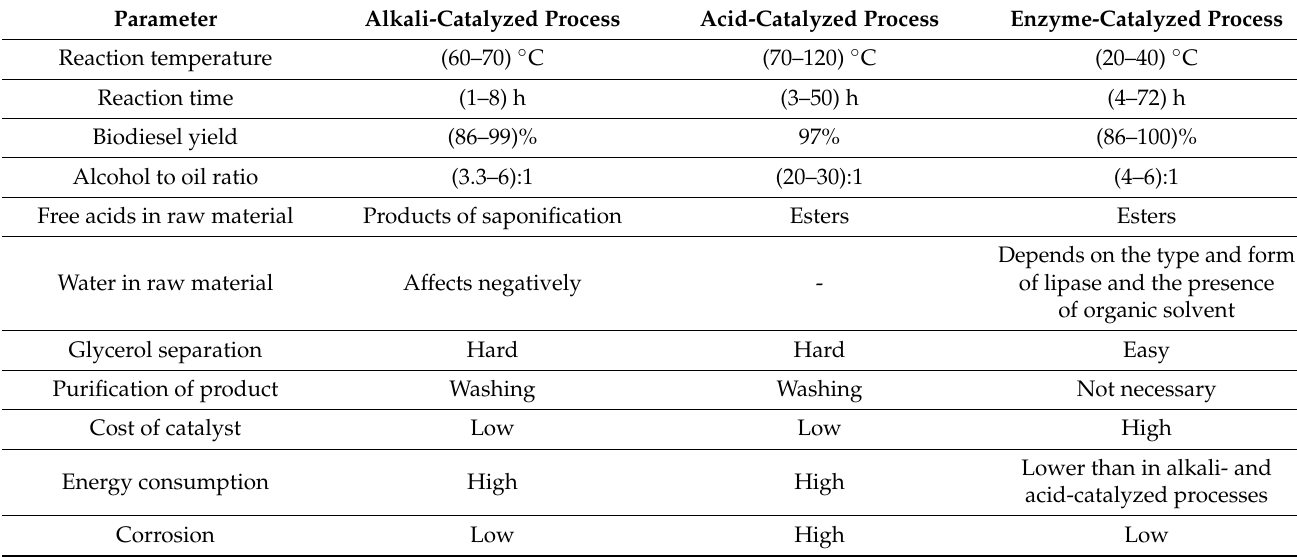
Table 1. Comparison of transesterification methods with the use of different types of catalysts [7,8,11,20,25,26,37].